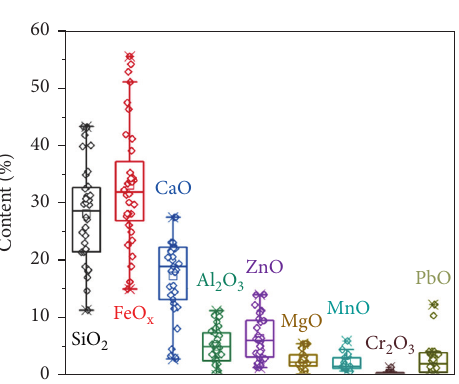
Figure 5: Major compositions of lead-zinc slag (data from Table